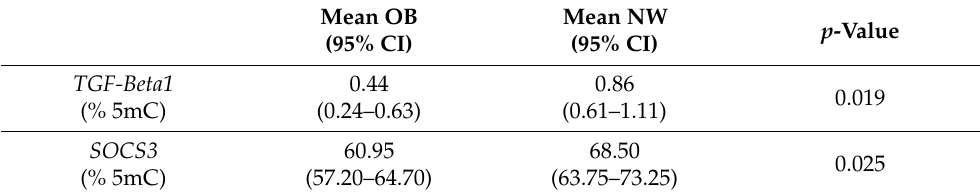
Table 6. TGF-Beta1 and SOCS3 methylation